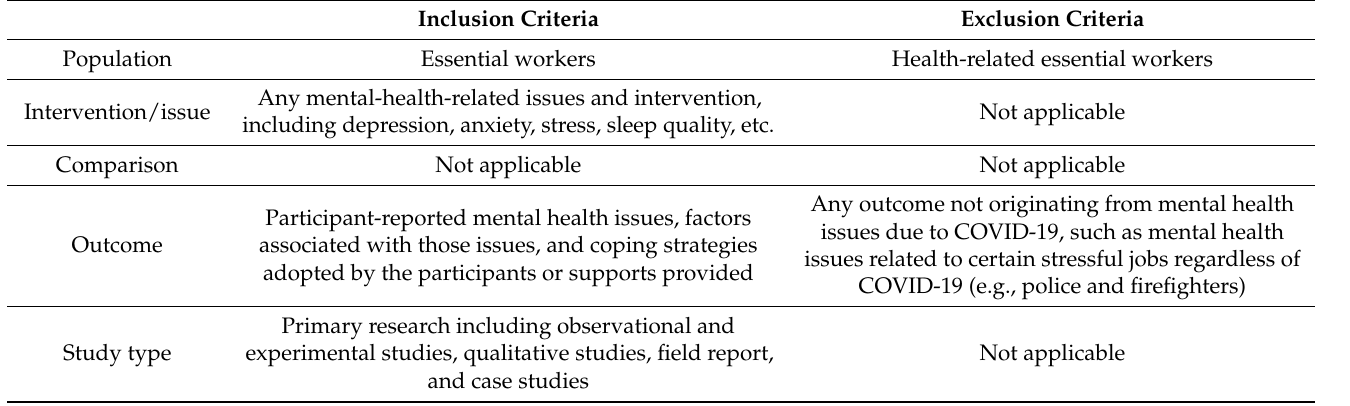
Table 3. Inclusion and exclusion criteria. Inclusion